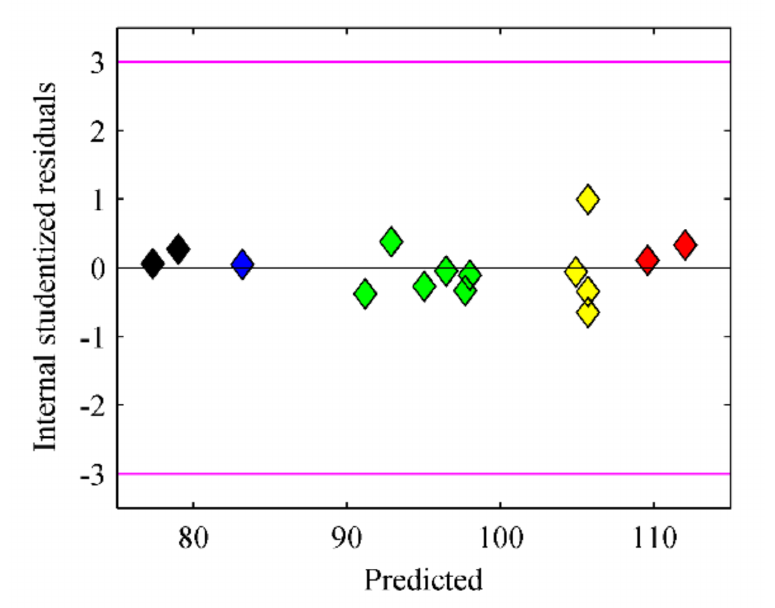
Figure 5. Corresponding relationship between the model residual and predicted value (Different colors indicate different ranges of actual value of average desulfurization rate).